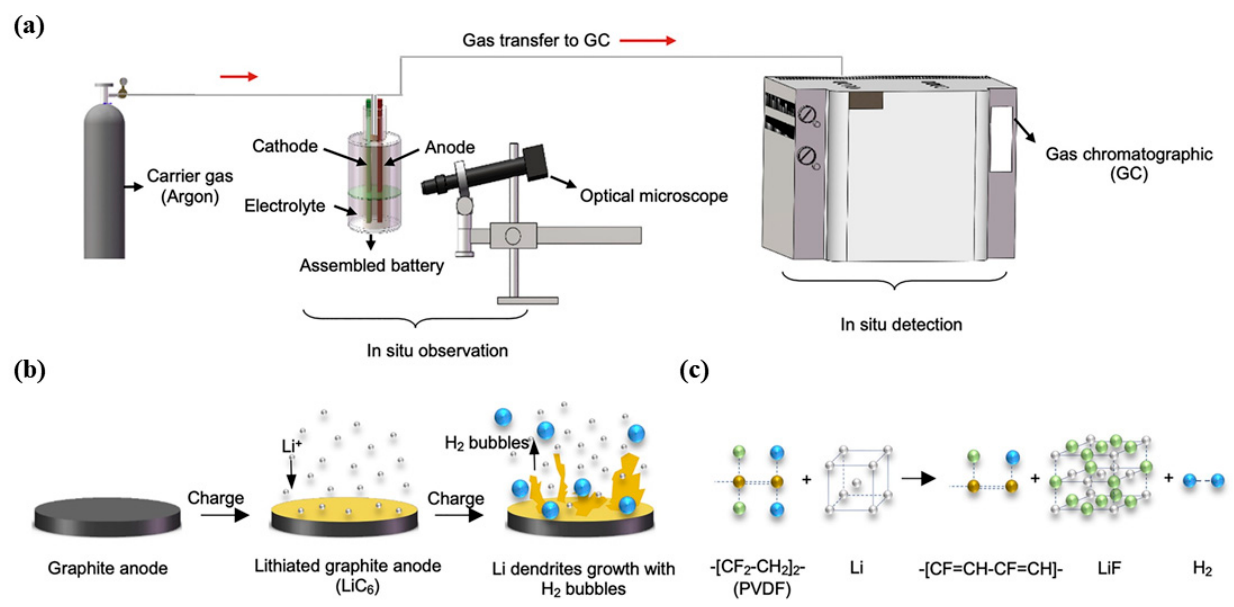
Figure 10. Sensitive TR monitoring and warning system based on capturing H 2 [109]: ( a ) Li dendrite growth observation and H 2 capture system, ( b ) H 2 generation mechanism and ( c ) Reaction mechanism of Li dendrites and PVDF binder.